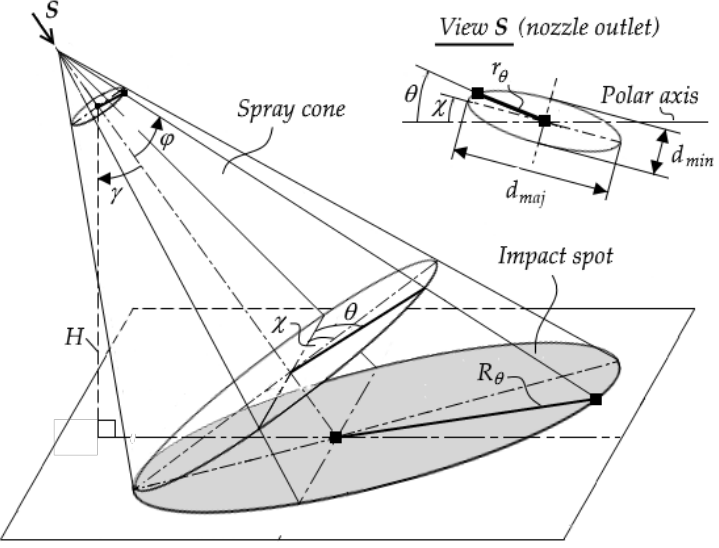
Figure 3. Schematic explaining the designations used in calculating the dimensions of the impact spot of the spray jet.